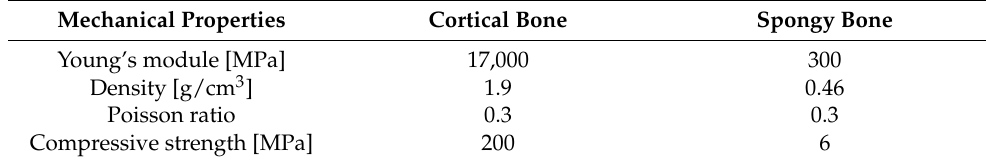
Table 1. Mechanical properties of the bone tissue of the